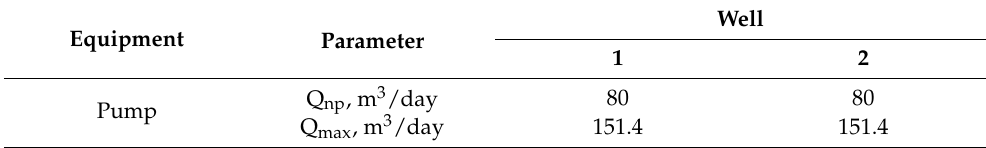
Table 1. Oil well equipment